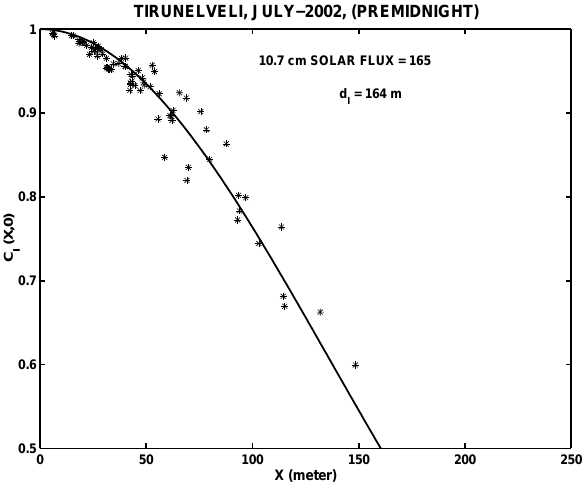
Fig. 2. C I (x, 0 ) as a function of x for the pre-midnight period of weak scintillations during July 2002.